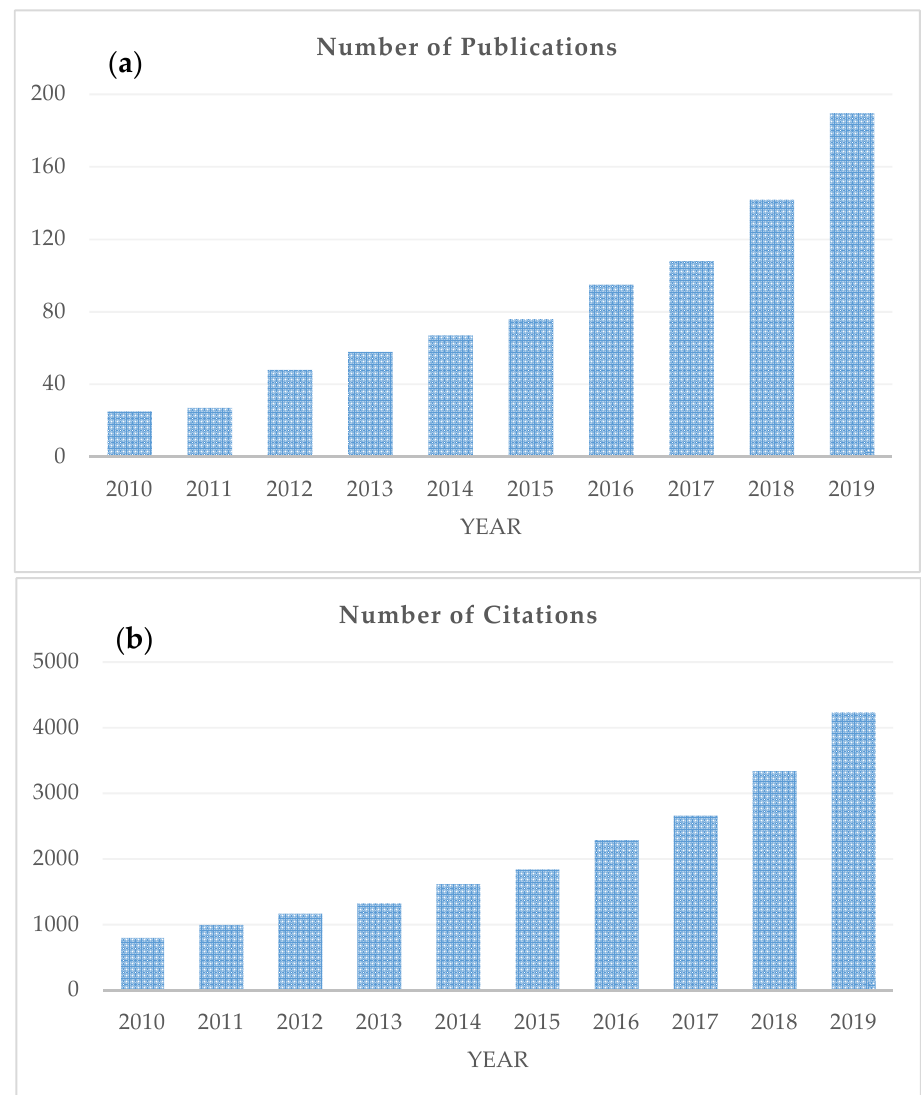
Figure 1. The number of publications ( a ) and citations ( b ) related to the application of spectroscopic techniques in the context of natural preservatives. Information obtained from the database Scopus